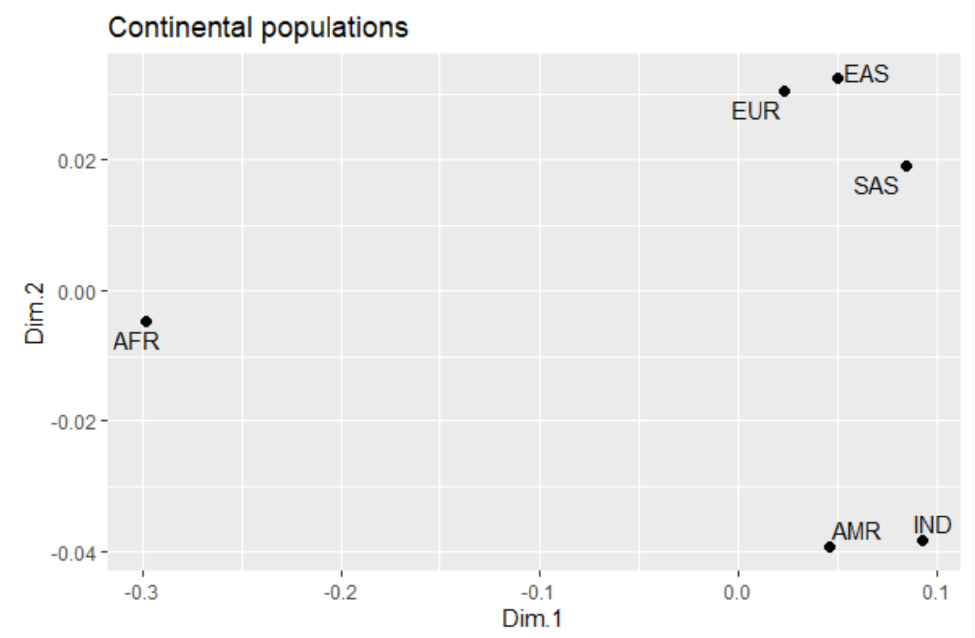
Figure 1. Multidimensional scaling plot illustrating the grouping of ethnic populations according to the genetic profile of the 15 variants in the BRCA1 and BRCA2 genes.